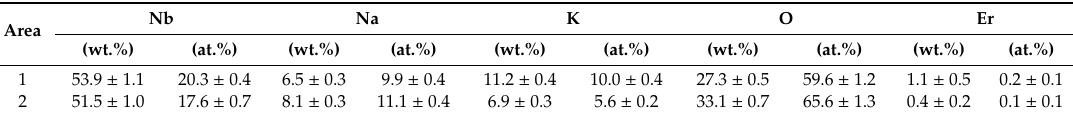
Table 5. An average elemental composition measured by EDS for KNN taken from two flat areas of the polished N5E1